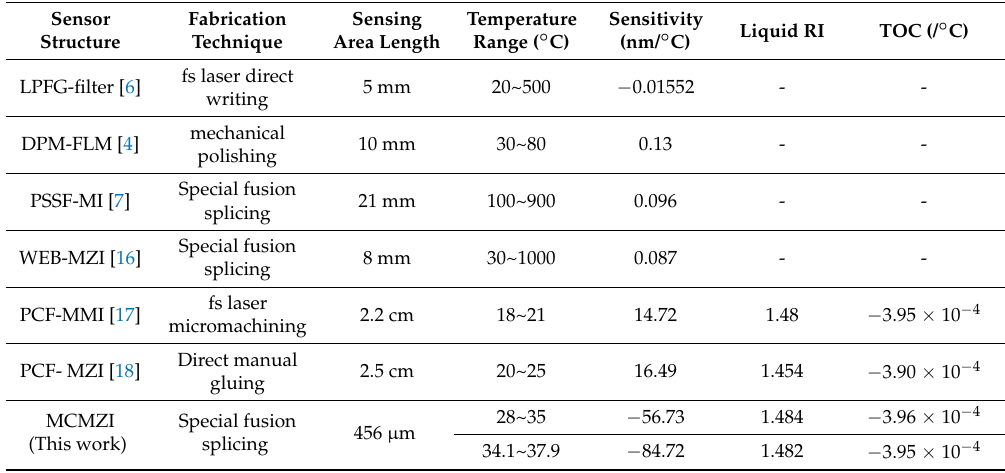
Table 1. Comparison of various fiber temperature sensors based on different structures and fabrication